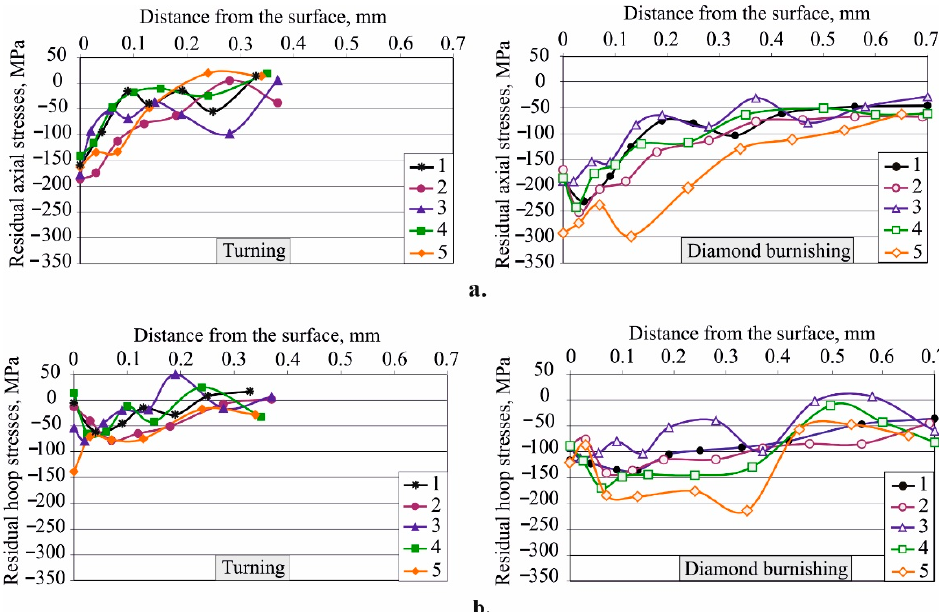
Figure 11. Residual stress distribution: ( a ) axial, ( b ) hoop: 1—as received, 2—annealed, 3—quenched, 4—quenched and tempered at 600 °C, 5—quenched and tempered at 300 °C.